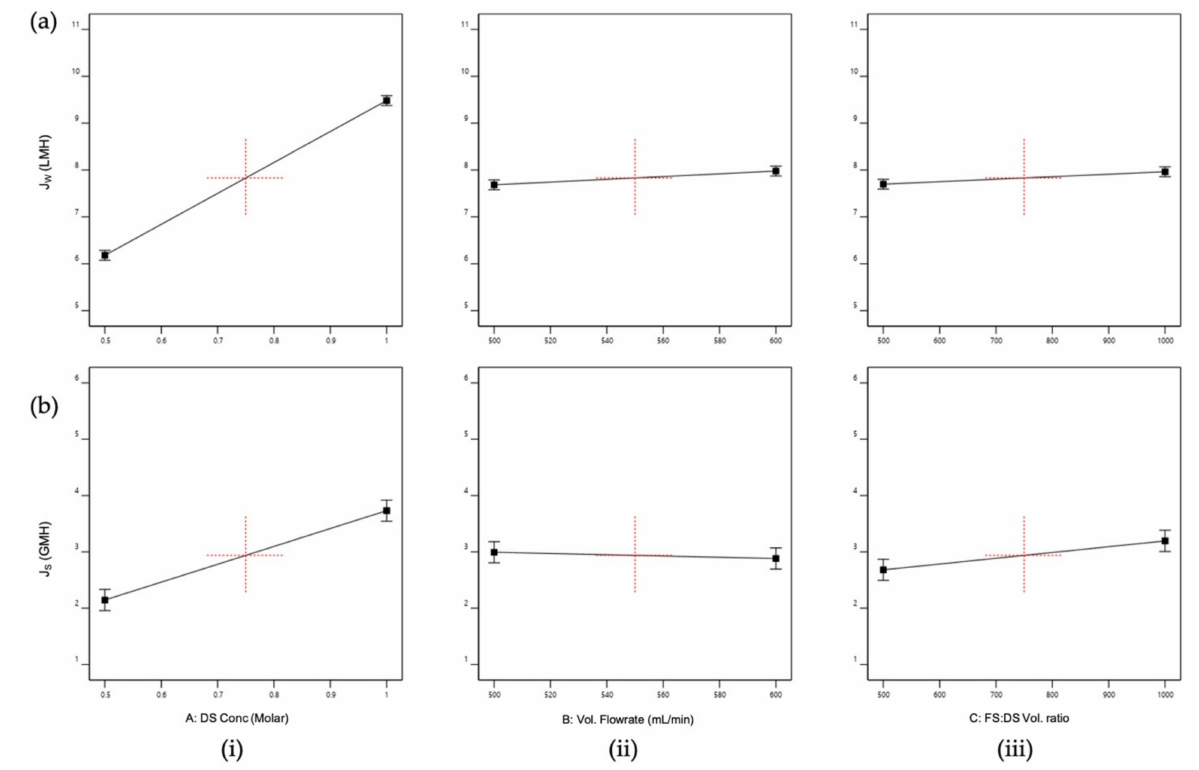
Figure 3. Main effects plots for ( a ) Average water flux, J W ; ( b ) Reverse salt flux, J S ; where the main effects are ( i ) Draw solution (DS) concentration, A; ( ii ) Volumetric flowrate, B; ( iii ) FS:DS volume ratio,